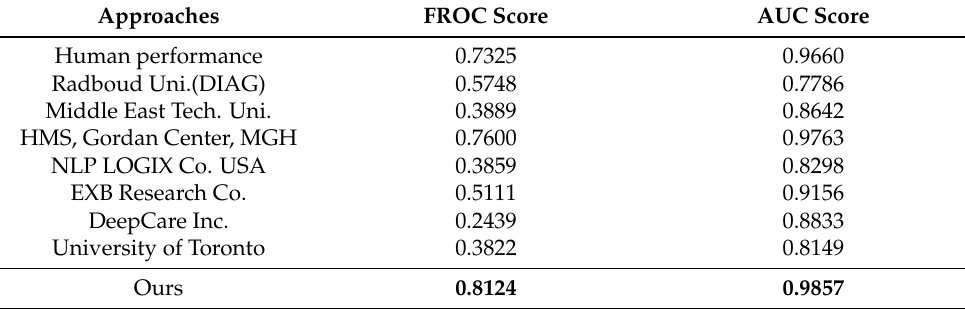
Table 4. Performance comparison on the Camelyon16 dataset.